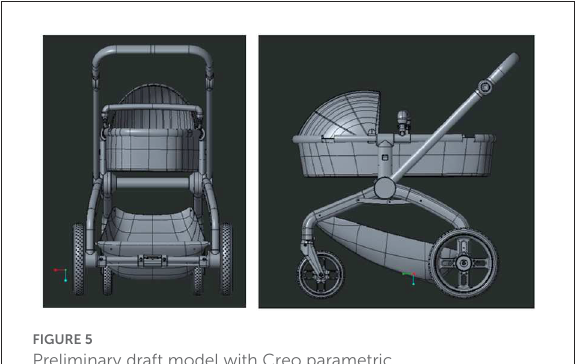
FIGURE5 Preliminary draft model with Creo